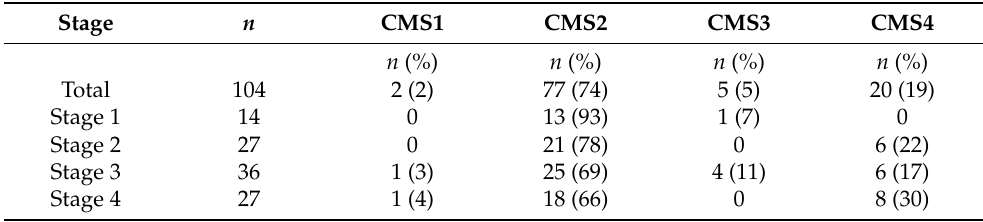
Figure 1. Comparison of the percentages of combined APC + TP53 mutations (MUT A + P) across CMS1-4 classes. ( A ) All 433 CMS1-4 CRC tumors; ( B ) 199 CMS1-4 CRCs with WT RAS/RAF; ( C ) 234 CMS1-4 CRCs with MUT RAS/RAF. Percentages of MUT A + P in each of CMS1-4 classes are indicated. p values are for two-tailed Welch t test. Table 2. Frequency of stage-wise combined AP mutations (RAS/BRAF Wild Type) across the CMS classification in Moffitt CRCs.